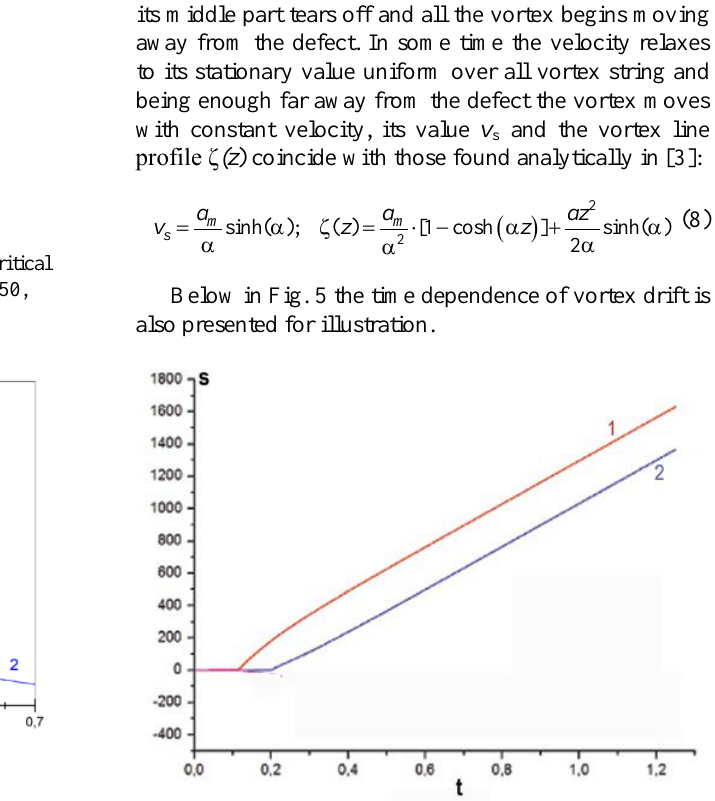
Fig. 3. Vortex edges locations (asterisk) on the external potential profile at near critical current a =350: 1 – z =0; 2 – z =1 ( a cr =353).